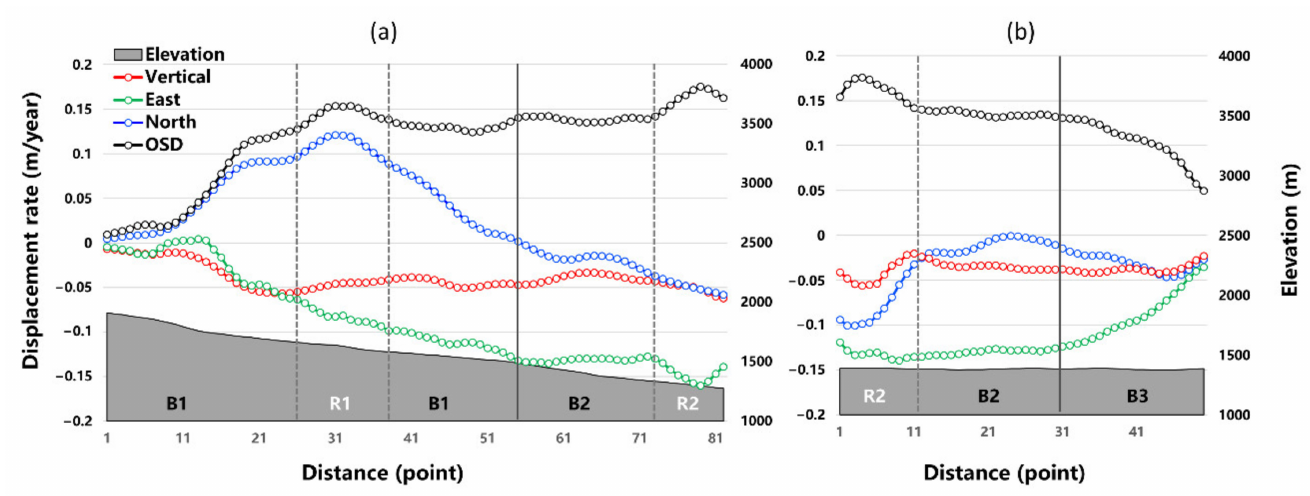
Figure 8. Elevation, three-dimensional displacement rates, and movement in the optimal sliding direction along the Profiles AA’ and BB’ label in Figure 7d. ( a ) Profile AA’ and ( b ) Profile BB’, where B1, B2, and B3 indicate blocks of Baobao landslide labeled in Figure 7a, and where R1 and R2 indicate active regions labeled in Figure